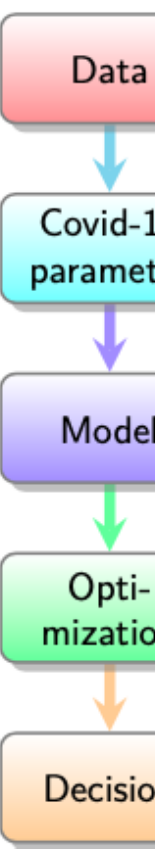
Figure 1. Data-Driven MFTG Model: Data, Covid-19 parameter, Model, Optimization, Decision and back to the data measurement. The verification-validation procedure used in this